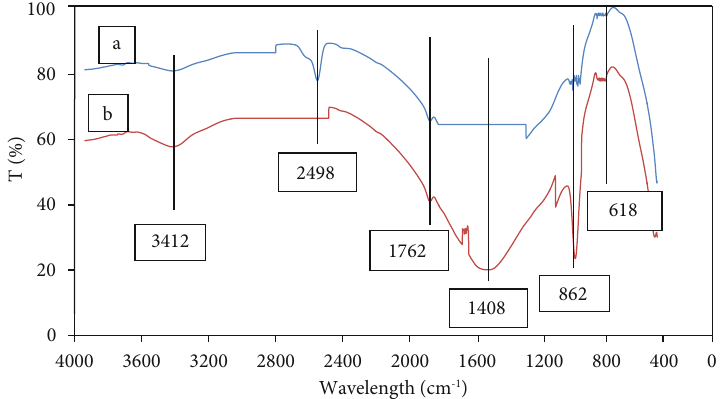
Figure 12: FTIR spectra of (a) Cucumeropsis mannii shell extract and (b) adsorbed fi lm on A515 Grade 70 CS surface.